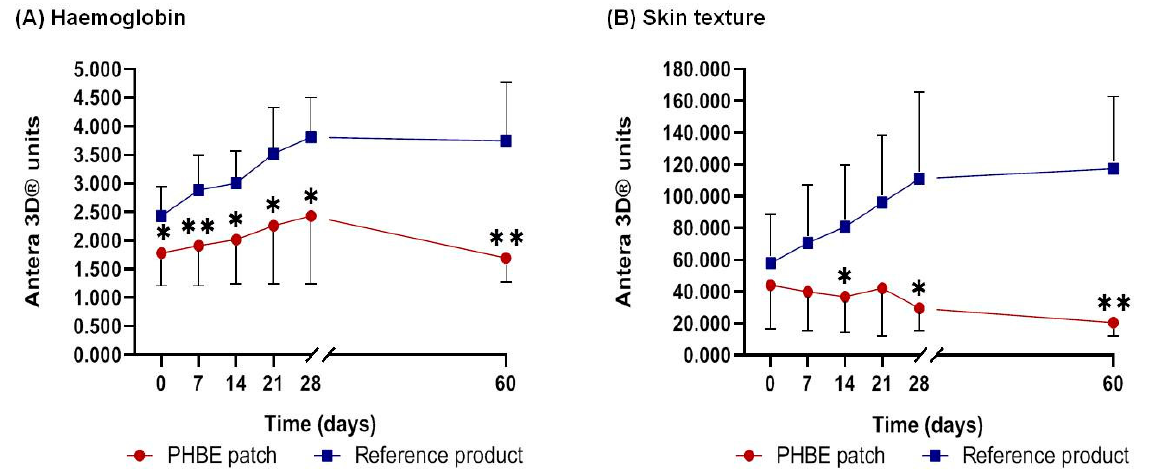
Figure 7. ( A ) Hemoglobin concentration and ( B ) skin texture value before radiation therapy (RT) (Day 0); during Days 7, 14, 21, and 28; and 1 month after RT (Day 60). Significant differences were recorded between the two interventions at most of the time points (* p < 0.05, ** p < 0.01). Hemoglobin concentration and skin texture value returned to the initial levels 1 month after RT (Day 60) in patients using the PHBE